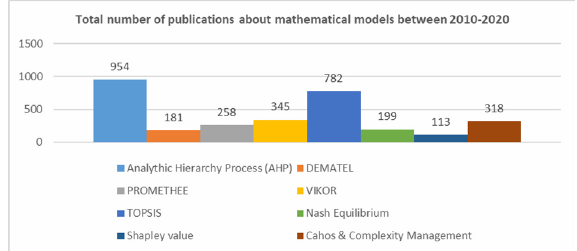
Figure 1. Publications about mathematical models.